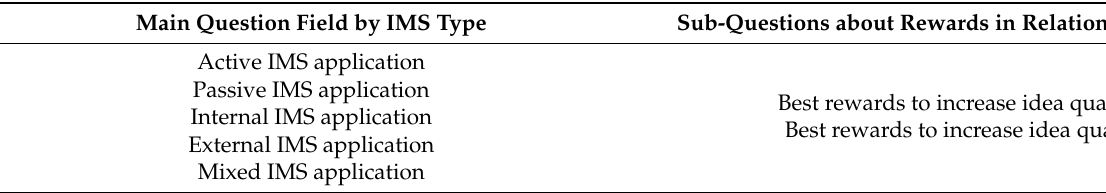
Table 6. Expert interview question